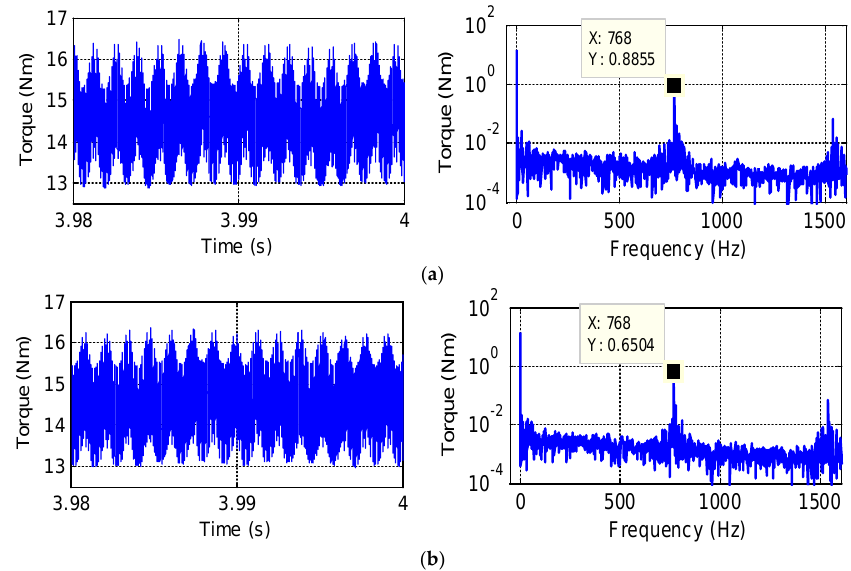
Figure 18. Waveforms and FFT results of torque at 1920 r/min: ( a ) Before suppression; ( b ) After suppression.